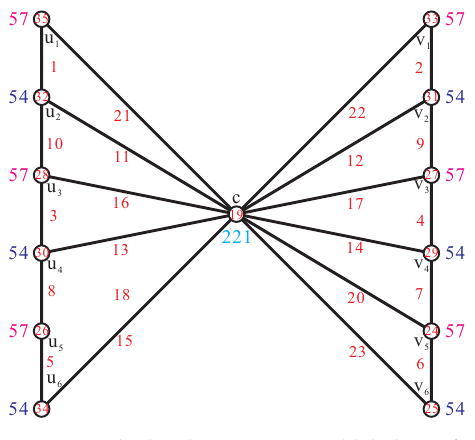
Figure 6. The local antimagic total labeling of B 6,6